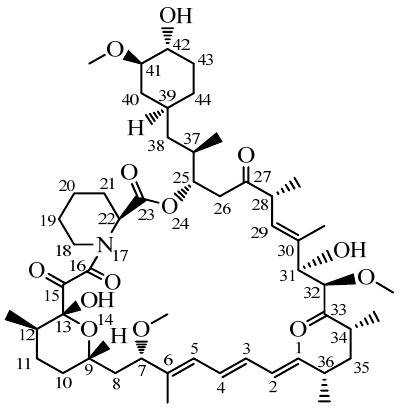
Figure 1. Structure of rapamycin